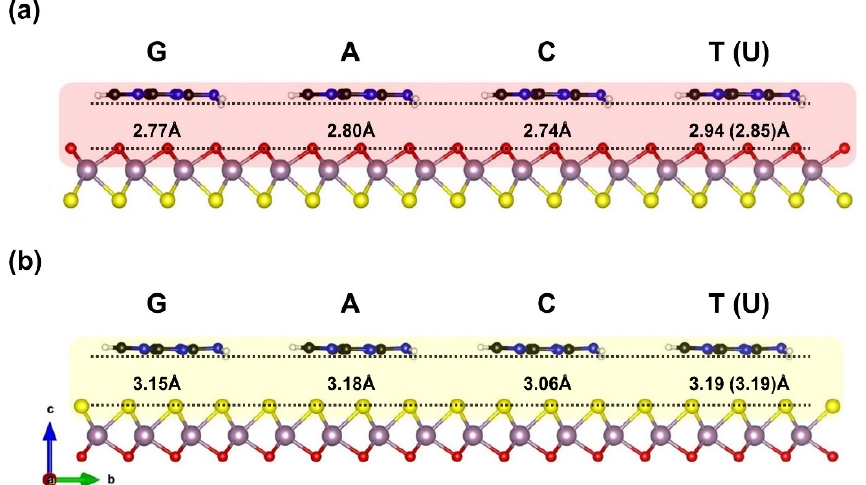
Figure 1. Adsorption configurations model and optimized nucleobases molecules distance above the Janus MoOS monolayer facets, ( a ) on O layer, ( b ) on S layer, respectively. Color code; purple: Mo, red: O, yellow: S, black: C, blue: N, white: H. It is found also that in all configurations, the center of pyrimidines (C 4 H 4 N 2 ) aromatic ring adsorbs similarly on the uppermost of the oxygen (sulfur) atomic layer. For A and G molecules, the second ring attempts to align its center with nearby oxygen (sulfur) of the top monolayer. On the other hand, the aromatic ring of the U molecule is remarkably aligned with the O layer (S layer), revealing the most symmetry nucleobase overall. Fur- ther, the atom next to the O layer (S layer) termination is a hydrogen (H), either from an amino (NH 2 ) or a methylene (CH 2 ) group, whenever these are found, or an oxygen (O)